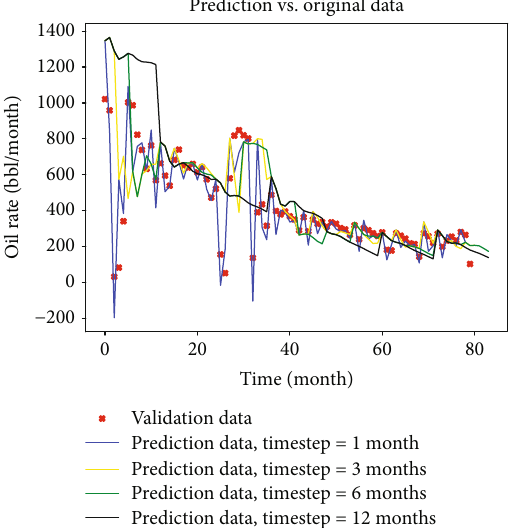
Figure 4: Comparisons between oil rate data with predicted data as the function of timesteps in Bakken